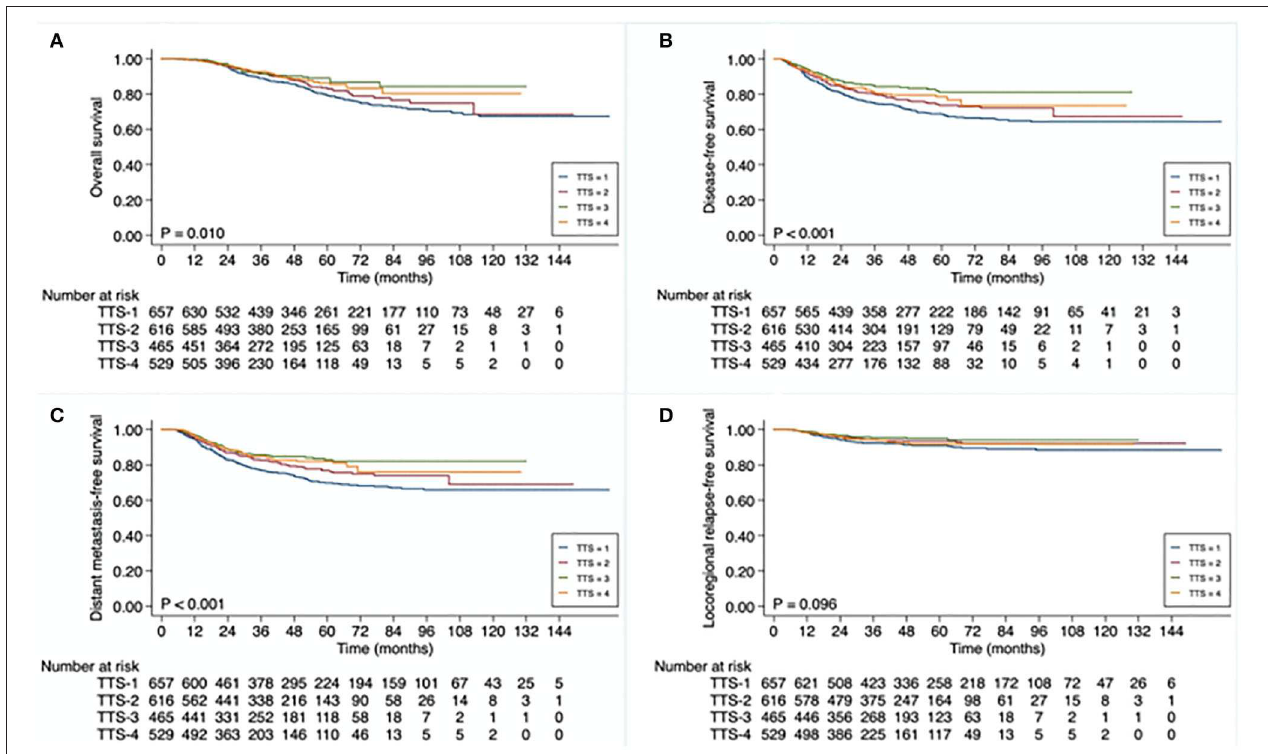
FIGURE 1 | Kaplan-Meier curve analysis of (A) overall survival, (B) disease-free survival, (C) distant metastasis-free survival, and (D) locoregional relapse-free survival (D) , based on total-time-to-surgery (TTS), of 2,267 patients with locally advanced rectal cancer. TTS defined as time from initiation of neoadjuvant treatment to date of surgery: < 13 weeks (TTS-1), 13 to < 15 weeks (TTS-2), 15 to < 17 weeks (TTS-3), ≥ 17 weeks (TTS-4).